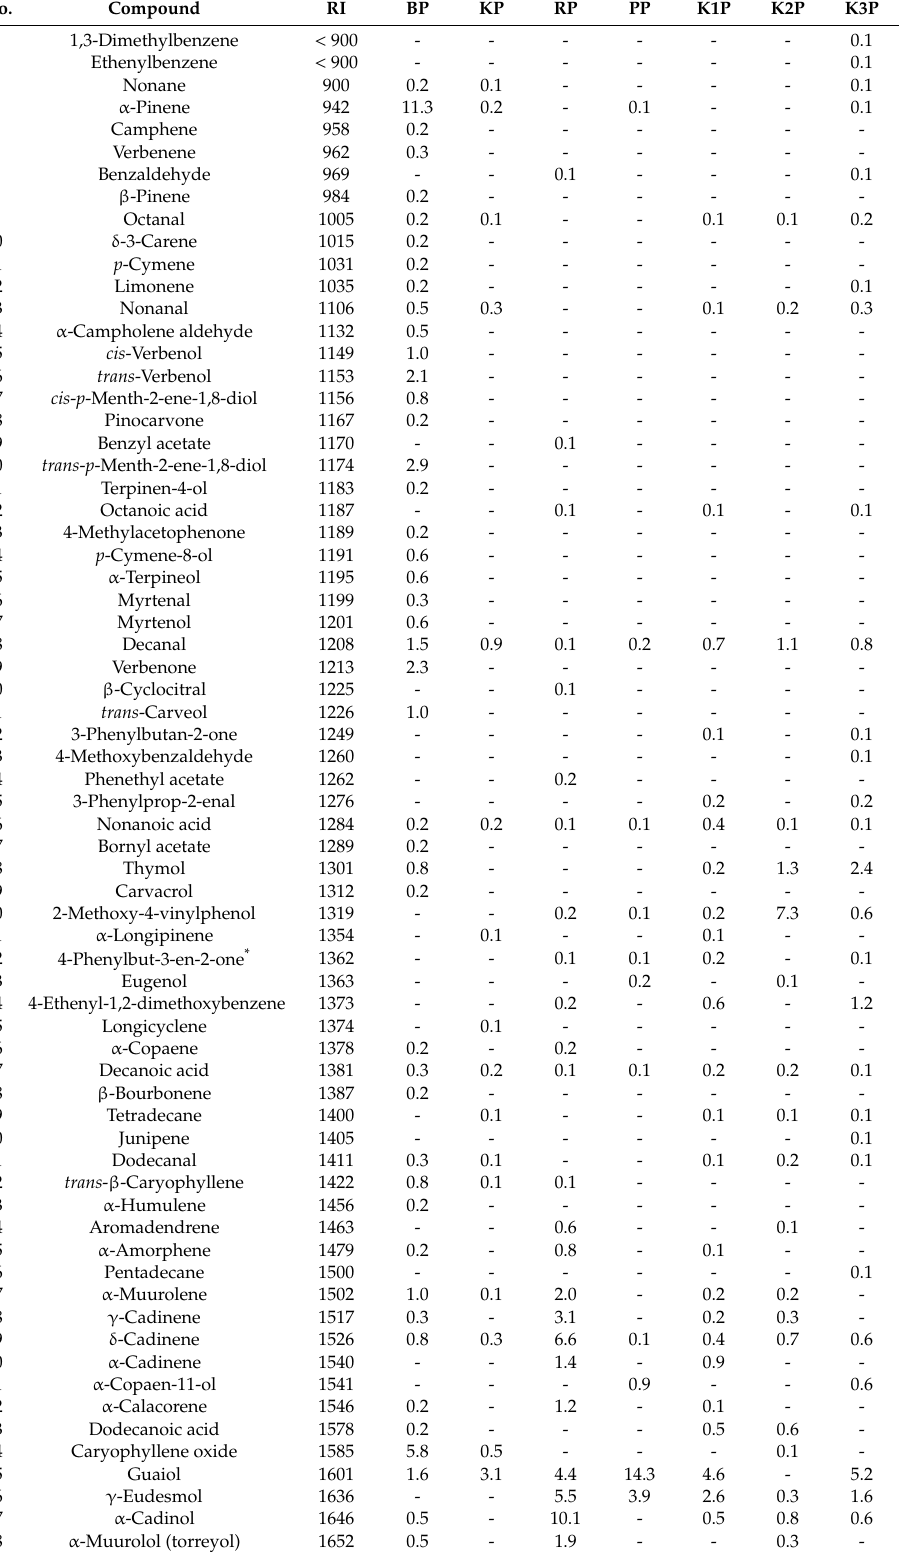
Table 2. Volatiles obtained by hydrodistillation (HD /